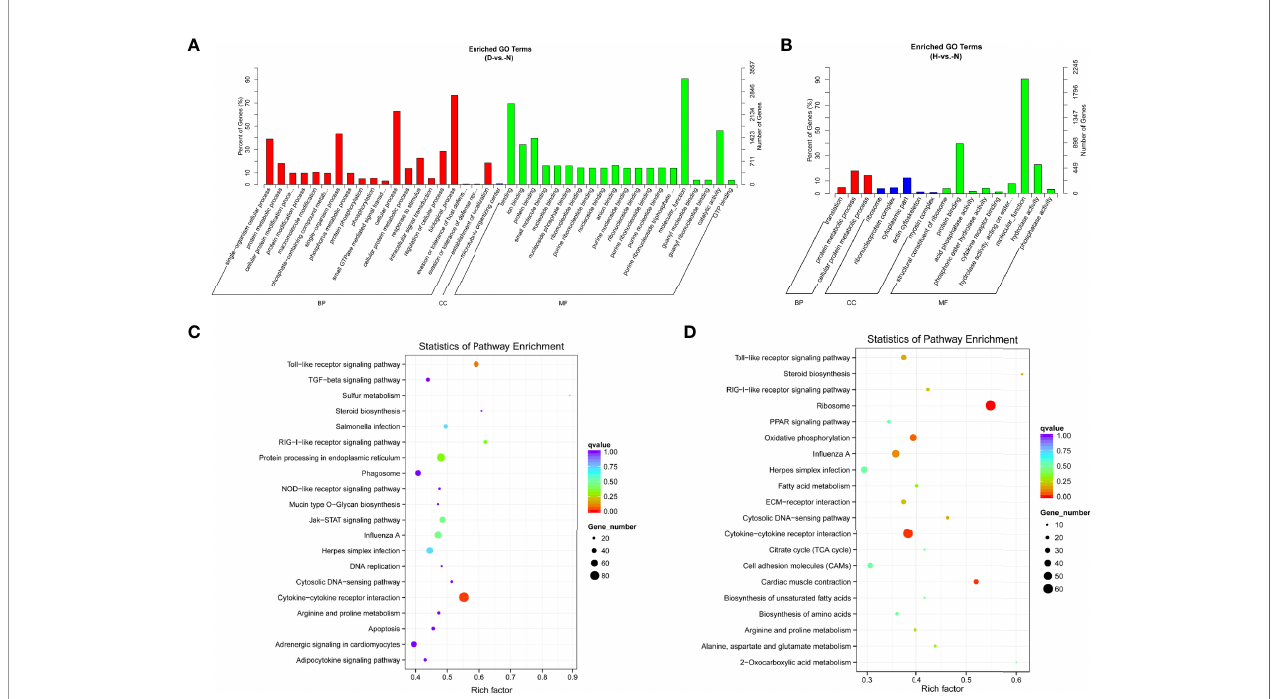
FIGURE 5 | GO enrichment analysis based on DE mRNA of D-vs.-N group (A) and H-vs.-N group (B) . KEGG analysis of the top 20 enriched pathways of DE mRNAs of D-vs.-N group (C) and H-vs.-N group (D) .